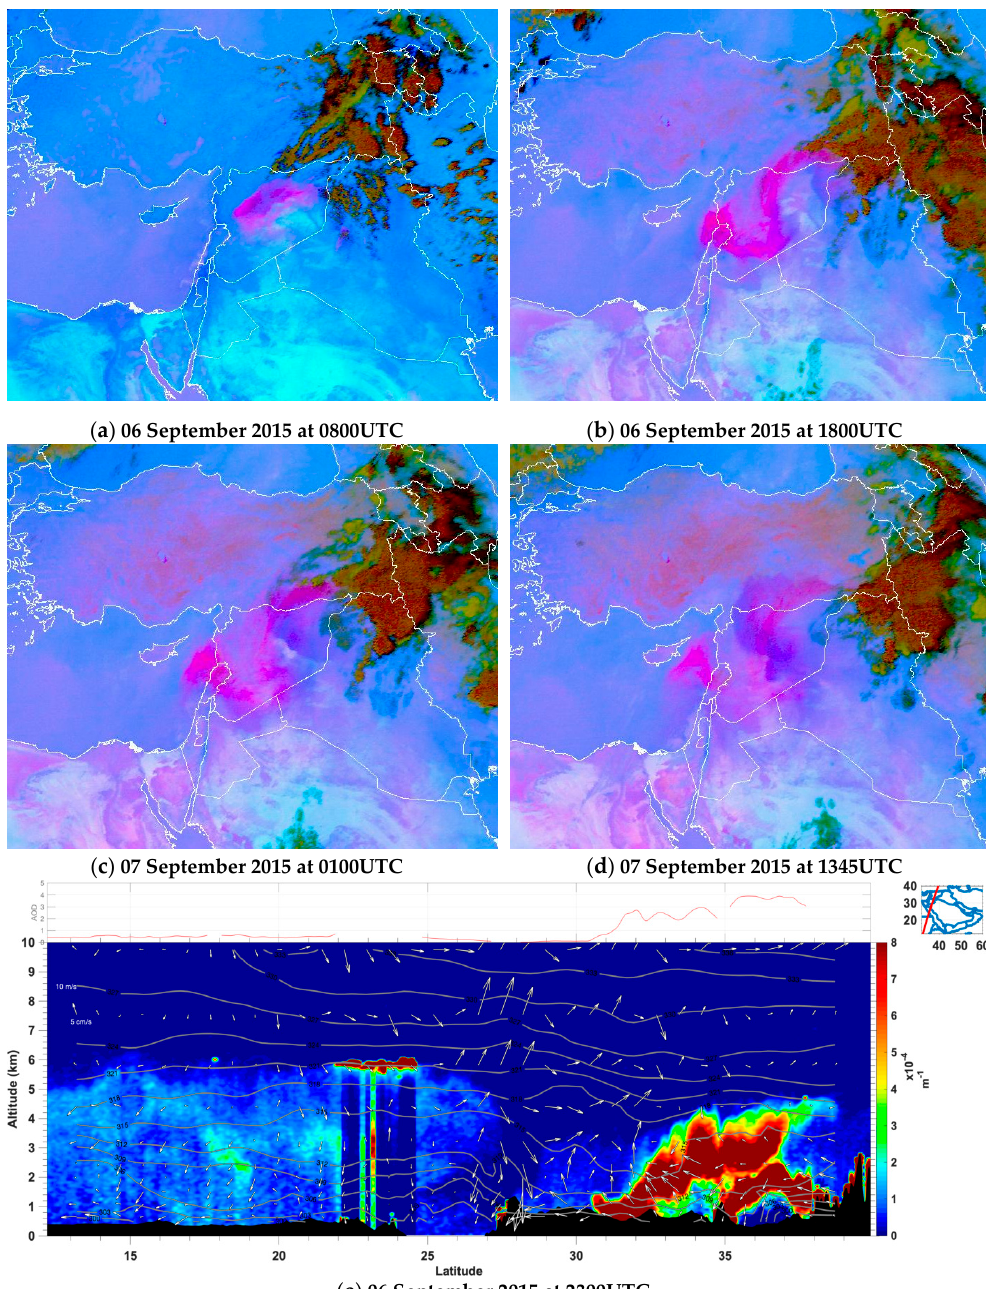
Figure 7. SEVIRI-derived false color images showing dust (pink/purple), clouds (brown/red) and differences in surface emissivity retrieved in absence of dust or clouds (light blue/blue) on 06 September 2015 at 0800UTC ( a ), 06 September 2015 at 1800UTC ( b ), 07 September 2015 at 0100 UTC ( c ), 07 September 2015 at 1345 UTC ( d ). ( e ) CALIPSO observations on 6 September 2015 at 2300UTC of particle extinction coefficient at 532 nm on which are superimposed the wind direction and vertical velocities in vectors and the isentropes derived from ECMWF ERA5 re-analyses along CALIPSO track. The upper panel shows the AODs derived from CALIPSO at 532 nm along its path on 6 September 2015. The panel in the upper-right corner shows in red the path of CALIPSO over the study area on 6 September